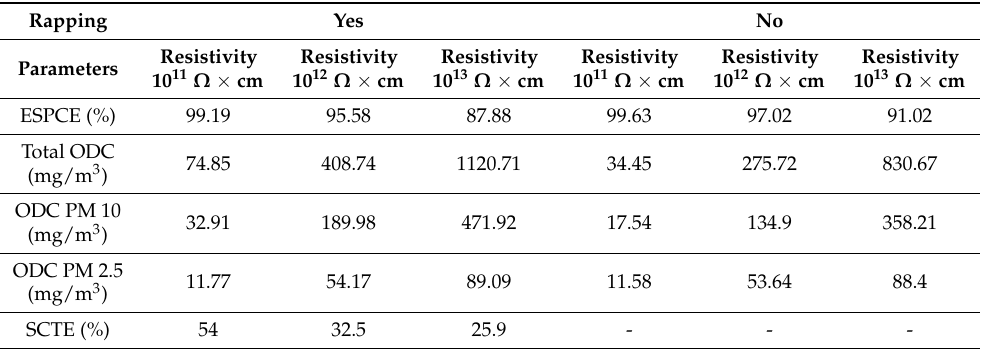
Table 15. Dust particle collection for a full-wave rectified voltage with a 2 mm dust layer on the section surfaces and for the dust resistivities when the electrodes are rapping versus when they are not rapping.